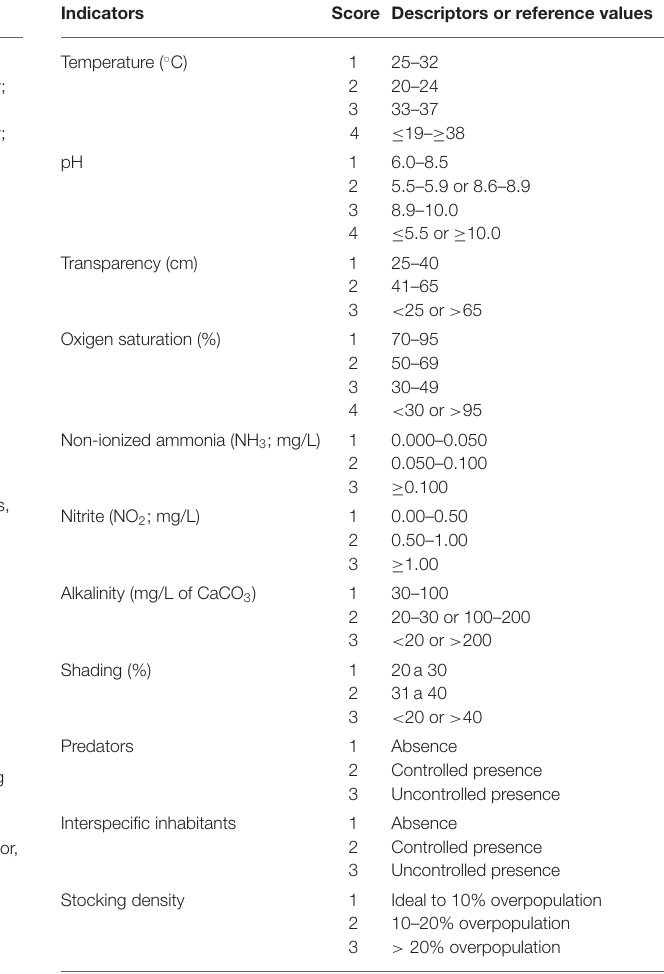
TABLE 2 | Health indicators based on Stien et al. (31), scores and descriptors or reference values adapted for on-farm tilapia welfare evaluation. Indicators